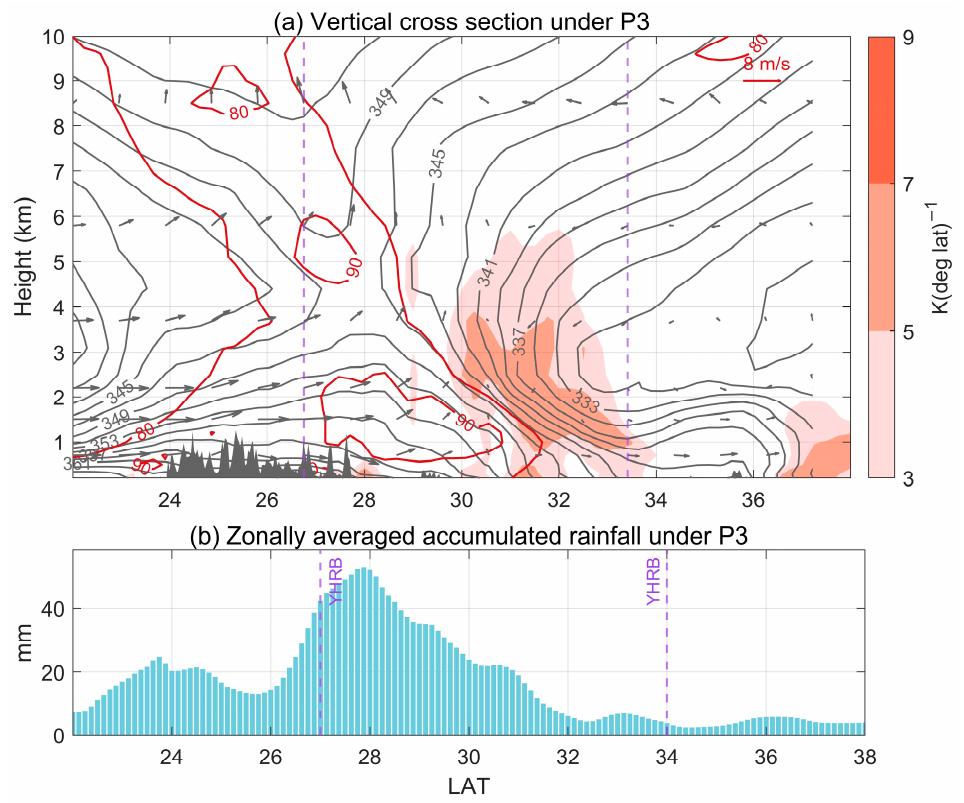
Figure 7. This is similar to Figure 5 but along 117° E under synoptic pa tt ern of